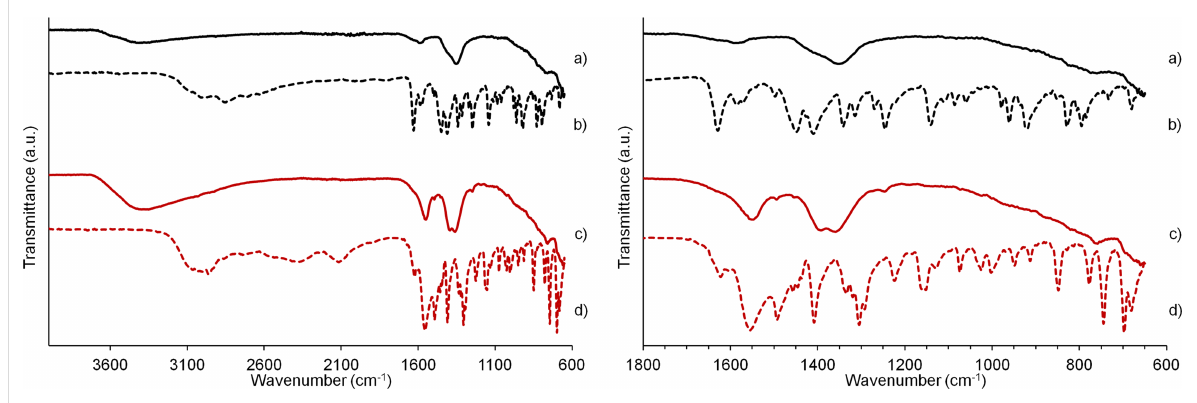
Figure 4: FTIR spectra of organo-modified Mg 2 Al hybrids: (a) LDH/HIS, (c) LDH/PHE and pristine amino acids: (b) L-HIS, (d) L-PHE (left side), zoom region on the right side.